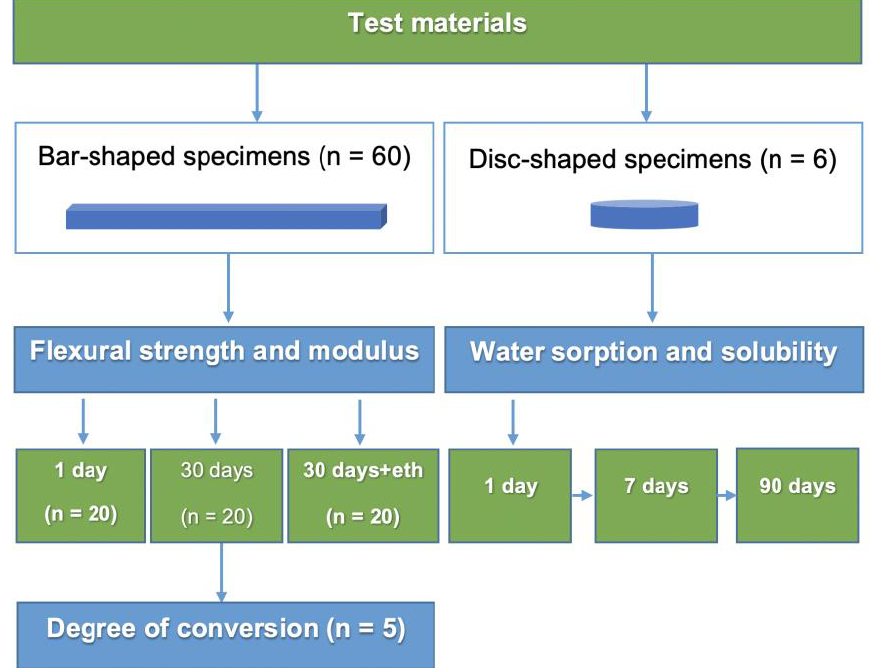
Figure 1. Flow chart of the experiments. Afterward, specimens were placed in a desiccator with freshly dried silica gel. Spec- imen were weighed on an analytical balance every day (NBL 254, Adam Equipment, Milton Keynes, United Kingdom) until the difference between the masses fell below 0.1 mg, i.e., until the equilibrium of the specimen mass was established. The measured value was the initial mass of the specimen (m 1 ). After that, each specimen was immersed in conical bottom plastic containers with 4 mL of saline, which were dark-stored in an incubator at 37 ± 1 ◦ C and weighed after 1, 7, and 90 days of immersion (m 2 (t); t denotes the interval from the beginning of immersion). During the measurement, the specimens were removed from the saline solution, blot dried with absorbent paper and air-dried for 15 s. After 90 days, the specimens were again placed in a desiccator, and their mass was weighed until they reached a constant value (difference in mass between measurements of less than 0.1 mg), indicating the final mass (m 3 ). The total desorption time was 26 days. Each specimen was weighed three times, and the mass of the specimen was determined by the arithmetic mean of the three measurements. Water sorption and solubility were calculated according to the equation provided by ISO 4049